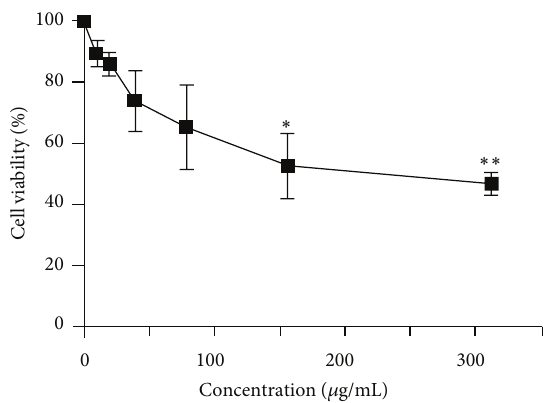
Figure 4: Cell viability versus the concentrations of leaf extract measured by MTS